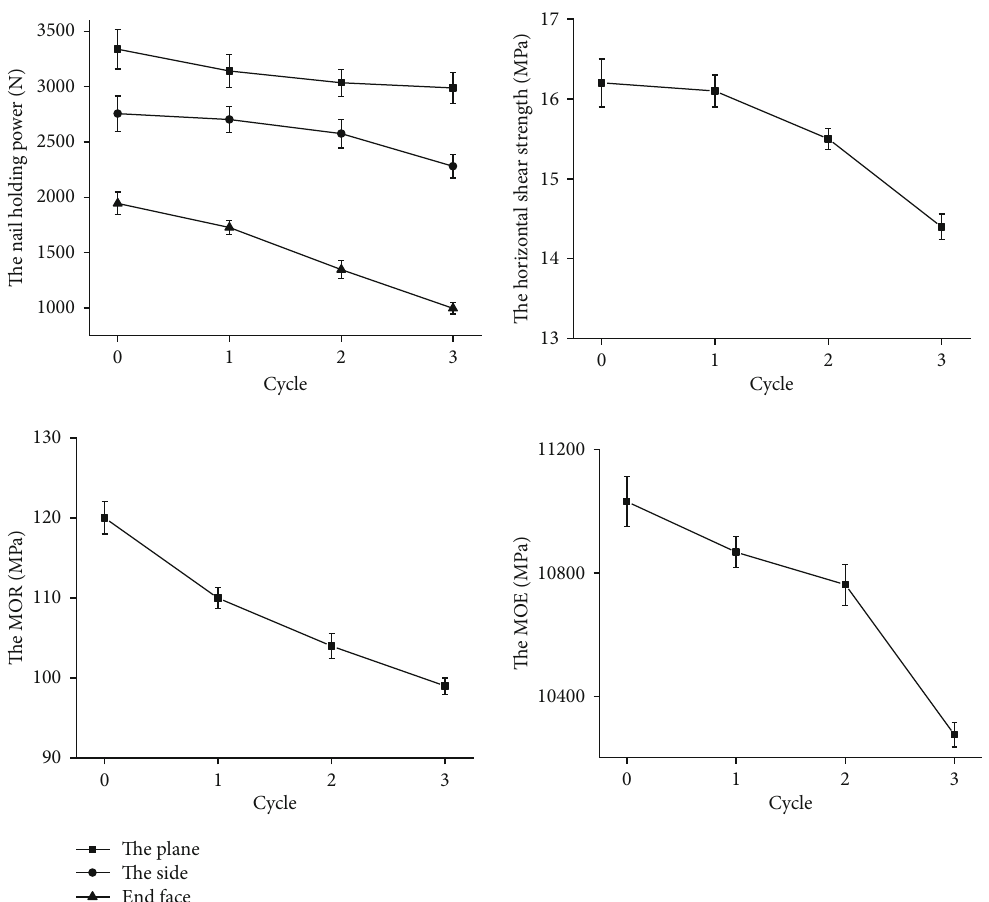
Figure 5: Results of the mechanical properties of bamboo scrimber after the wet circulation